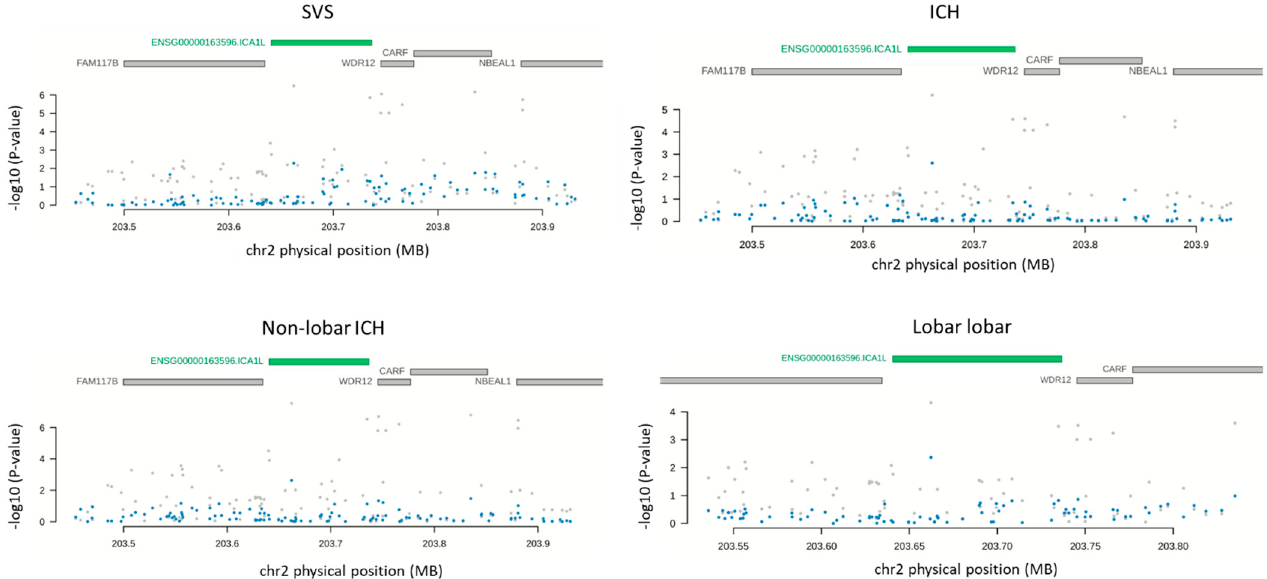
Figure 1. Significant SMR results for the significant and replicated PWAS results.Each “x” in figure represents a pQTL for ICA1L.